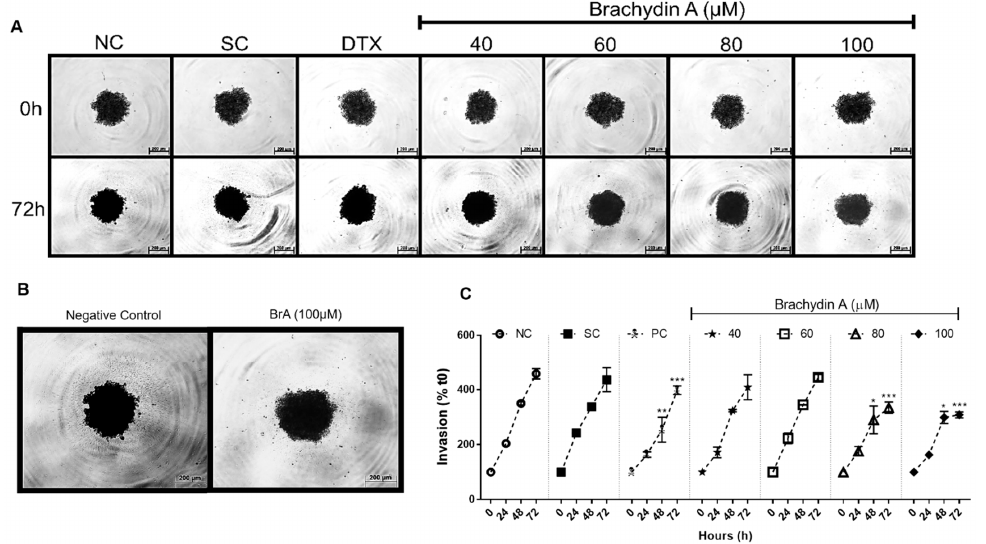
Figure 4. ( A , B ) Photomicrographs of DU145 spheroids in bovine skin gelatin after 0 and 72 h of exposure with Brachydin A (BrA) and respective controls. The images were acquired using the Axio Cam MRc image capture system coupled to an Axio LabA1 microscope, using the 10× objective, and analyzed using the AxioVision 3.1 software. Scale: 200 μ m. ( C ) Percentage (%) of cell invasion (invadopodia) formed by DU145 spheroids after 24, 48, and 72 h of exposure with BrA and respective controls. The invasion area ( μ m³) into the ECM (gelatin) was converted to % considering the area increase at 0 h. All data points represent the mean ± standard deviation of four ( n = 4) spheroids/replicates in three biological experiments ( n = 3). * Values statistically different from the NC group at that point (date) (* p < 0.05; ** p < 0.01; *** p < 0.001; ANOVA followed by Dunnett’s post-test). NC: negative control (RPMI 1640); SC: solvent control (1% DMSO); DTX: Docetaxel (50 μ M; positive control). Scale: 200 μ m.